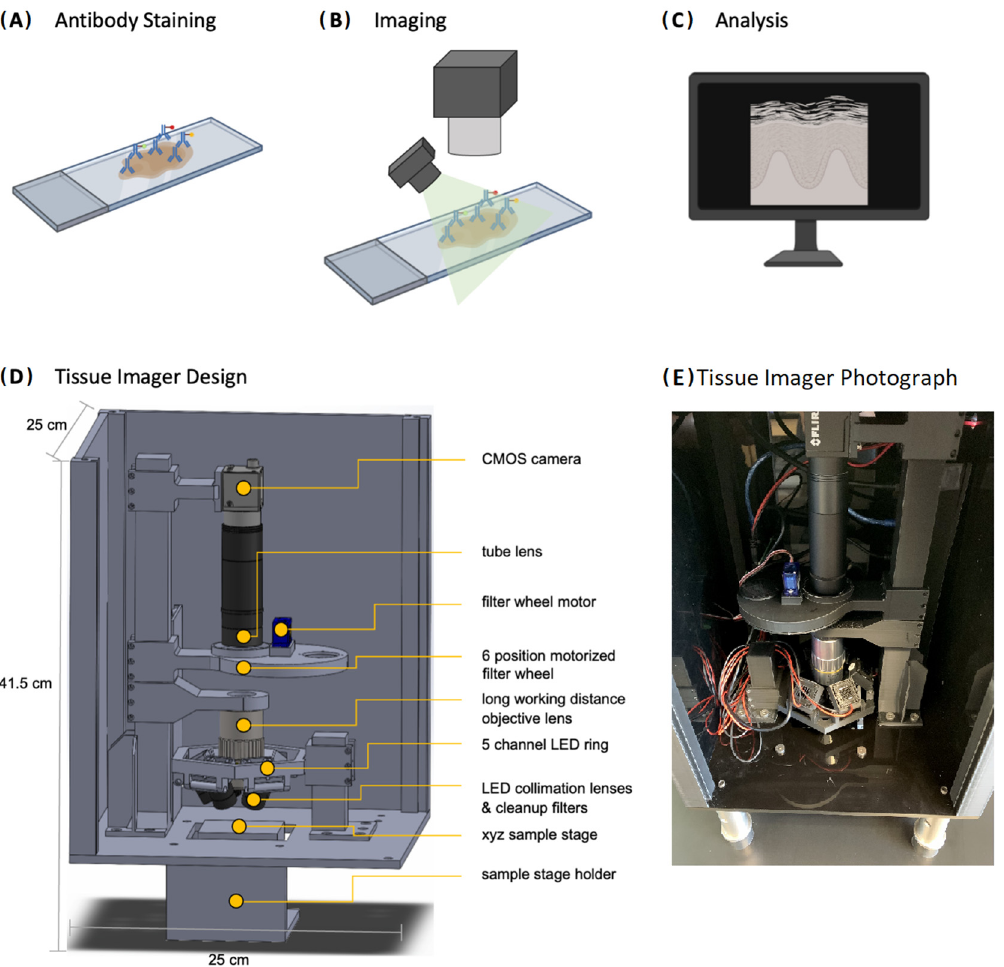
Figure 1. Workflow/design schematic. ( A ) Tissue samples are processed, and the protein markers are stained with antibodies. After blocking (e.g., typically with 10% BSA in this study), the primary antibody cocktail is placed onto the sample, followed by incubation with secondary labeled antibodies. ( B ) The sample is then imaged with the Tissue Imager. ( C ) The images are saved into a folder automatically and the images are then exported into ImageJ and/or CellProfiler for processing and quantification. ( D ) Tissue Imager CAD design with 20-megapixel CMOS camera, motorized filter wheel, 10 × objective lens, five excitation LEDs, and sample stage holder. ( E ) Photograph of the Tissue Imager with enclosure panel